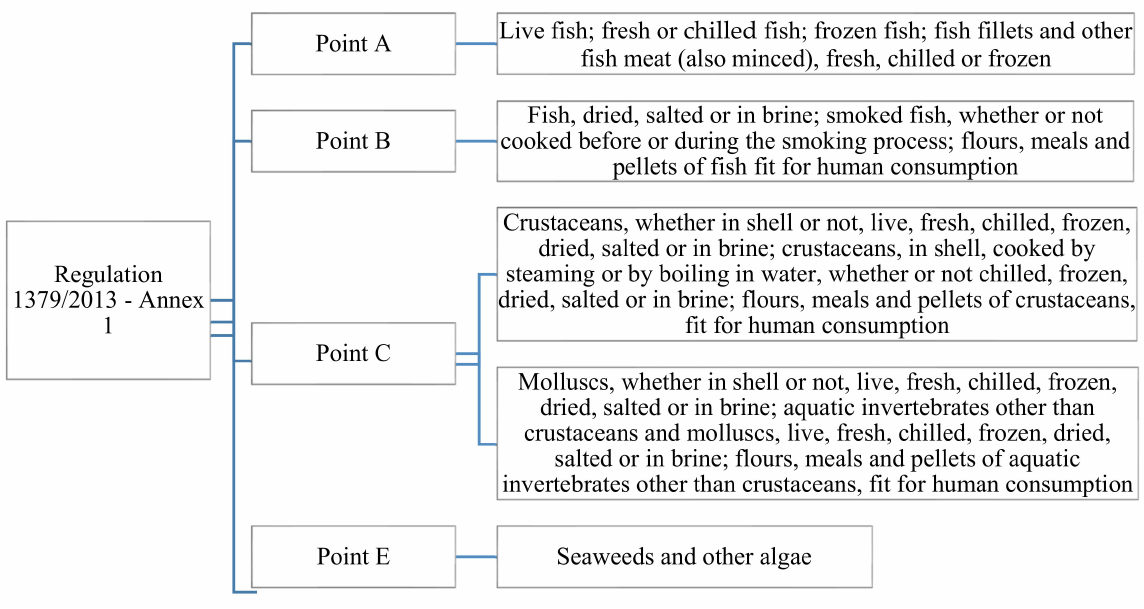
Figure 2. Processed FAPs covered by Annex 1, point a, b, c, and e of CMO Regulation 379/2013. Source: Our compilation from Regulation (EU) no 1379/2013 of the European Parliament and of the Council of 11 December